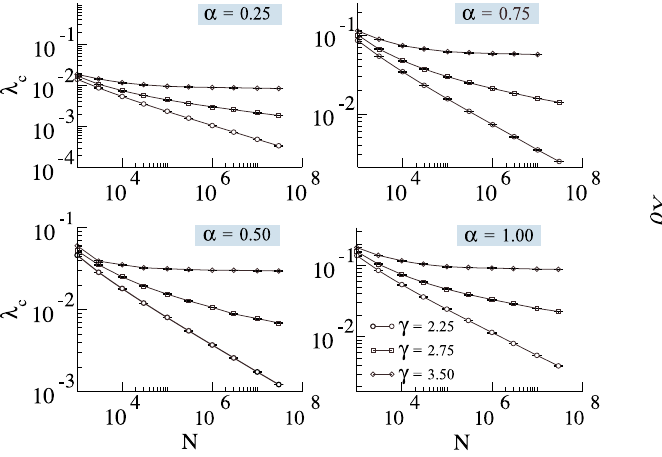
Fig. 7 Temporal behavior of the density of spreaders for an uncorrelated power-law network. Result for a network with N = 10 6 , γ = 2.25, α = 0.5 and δ = 1 in the regime λ ≪ δ for values of λ near the critical point λ ≈ c